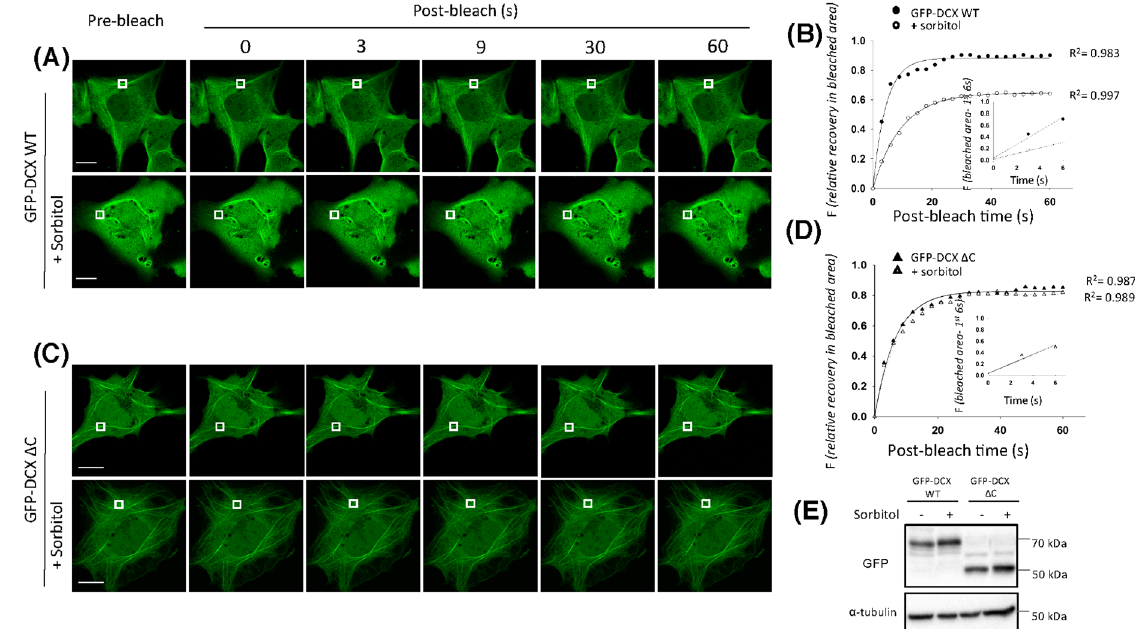
Figure 5. FRAP analysis reveals that hyperosmotic stress conditions impact GFP-DCX dynamics of association with MTs. COS-1 cells were transfected to express ( A , B ) GFP-DCX WT or ( C , D ) GFP-DCX Δ C. Cells were exposed to sorbitol (0.5 M, 1 h) to induce hyperosmotic stress. A FRAP protocol with a small bleach area and measuring recovery into the bleached area was utilized ( A – D ). A small ROI (indicated by the white rectangle in each cell image) was photobleached in ( A ) and ( C ) and the fluorescence recovery subsequently monitored at 3 s intervals for 60 s. Plots of the recovery of fluorescence in small area of bleach in DCX WT ( B ) and DCX Δ C ( D ) constructs in the presence and absence of sorbitol treatments are shown. Regression values for the accuracy of the respective curve fits are shown. Insets represent the recovery of fluorescence in bleach area for first three time-points (0–6 s of post-bleach) with the line of best fit used for the calculation of initial rate. ( E ) Equivalent expression of the GFP-DCX constructs was detected in the presence and absence of sorbitol by immunoblotting for GFP (upper panel), with equivalent protein loading detected by immunoblotting for total α -tubulin (lower panel). Scale bars represent 10 µ m. See Fig. 6 for quantitative pooled data.